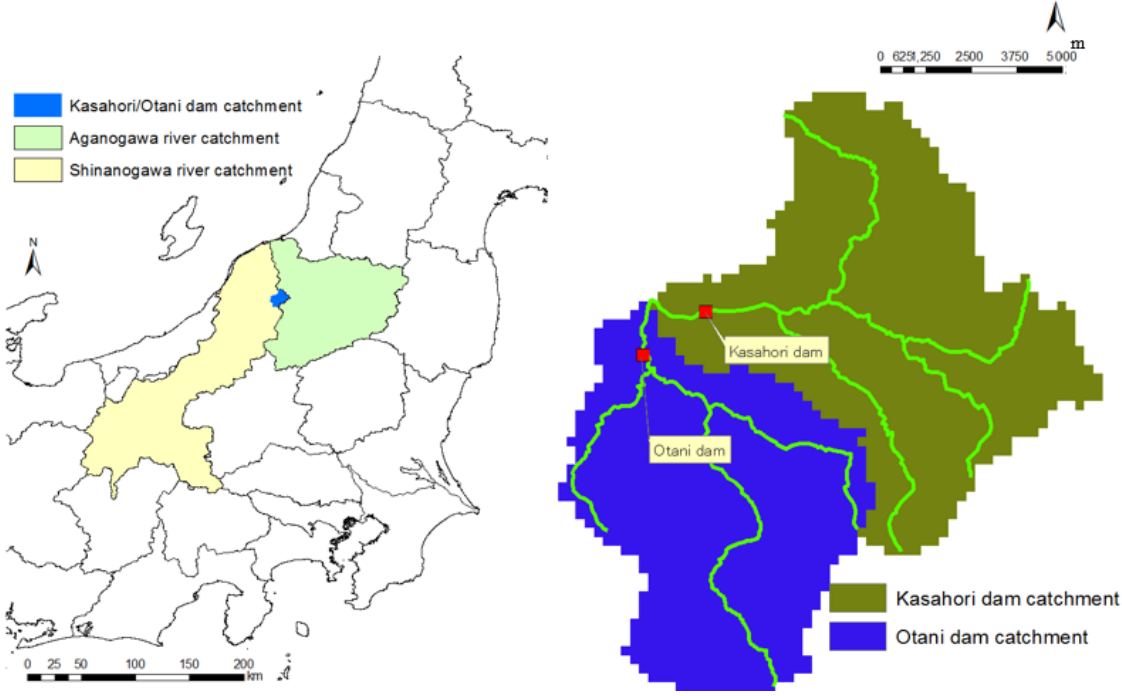
Figure 2. Shinano and Agano river catchments (left). Kasahori dam and Otani dam catchments (right).